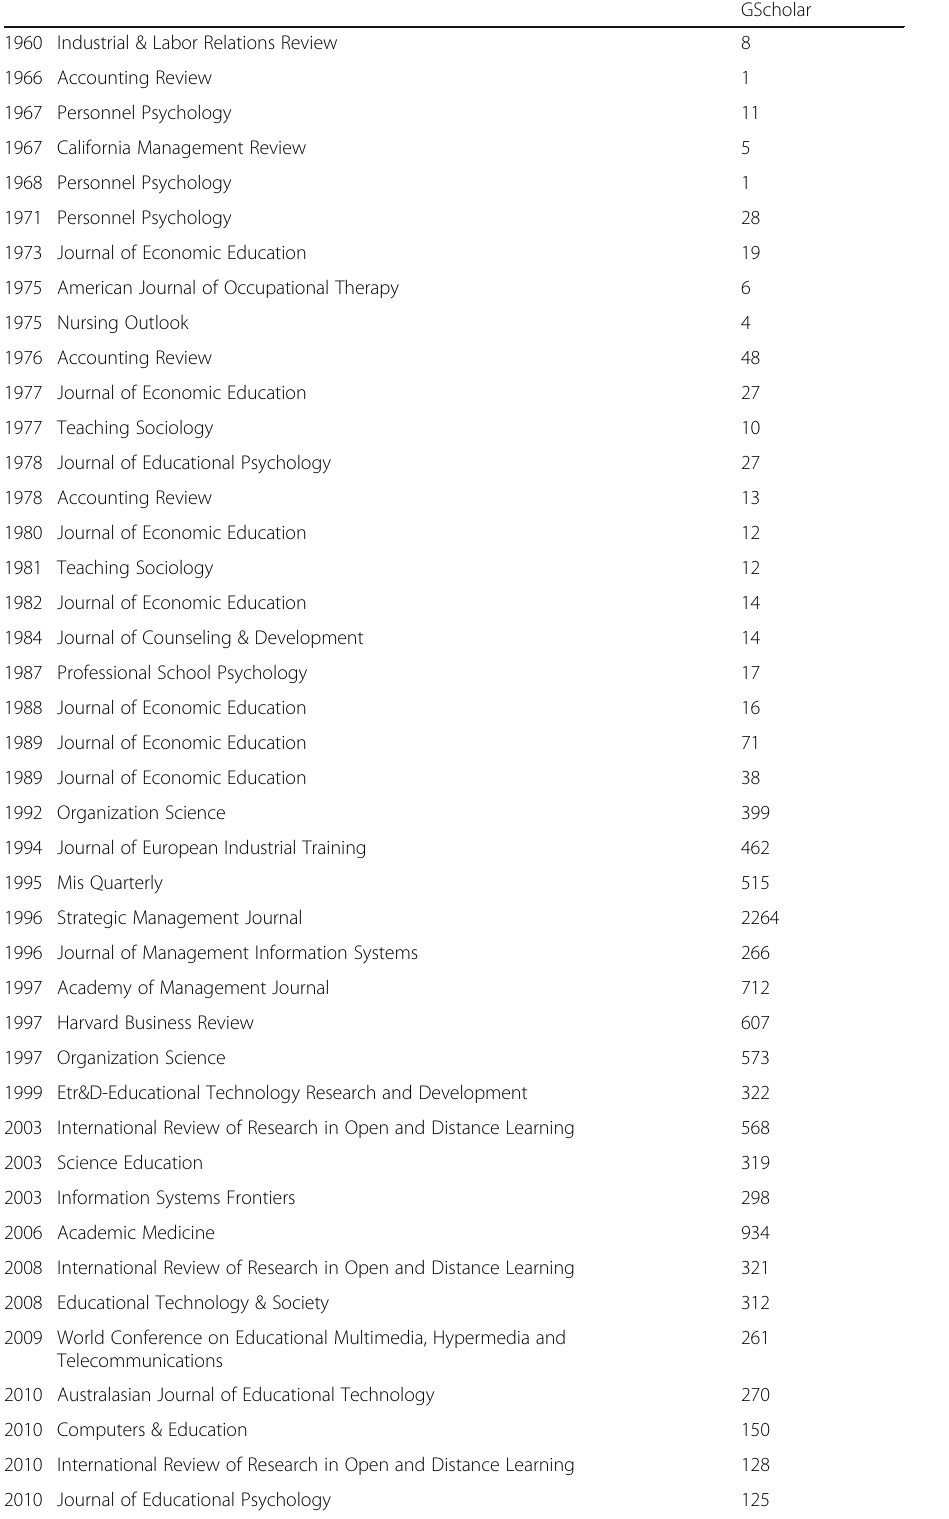
Table 2 Initial sample of work: year, source and number of citations in Google